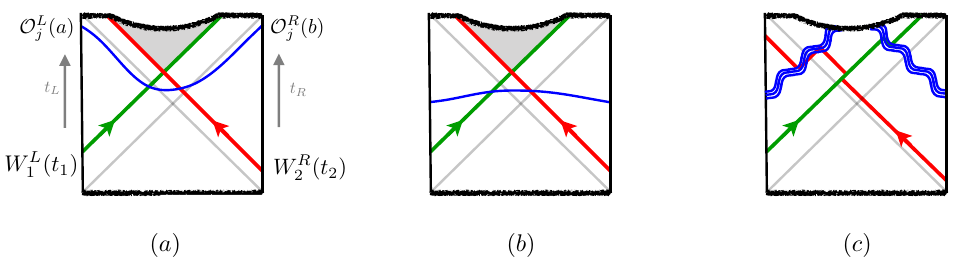
Figure 1 . The three setups we consider in this paper. ( a ) Scattering experiment in the eternal AdS black hole geometry dual to the thermofield double state. Two perturbations are inserted, one on the left and one on the right, and we probe the state using a two-point function of O j on a later time slice. ( b ) The same setup but with O operators inserted at a = b = 0 serves to j quantify the two-sided scrambling process and the ‘overlap’ of the two growing perturbations. ( c ) A coupling between the left and right theories modifies the time evolution in such a way that the wormhole becomes traversable and we can extract information about the scattering process behind the